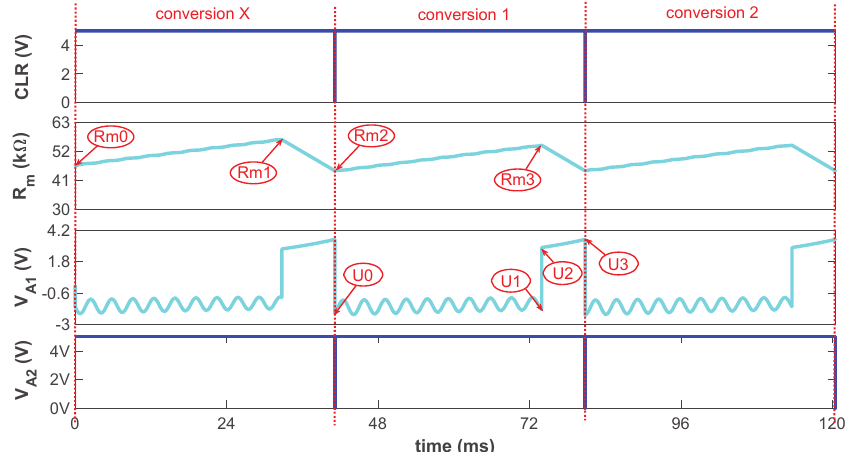
Figure 4. The memristance variation and the output voltage change under the input voltage with sine noise.